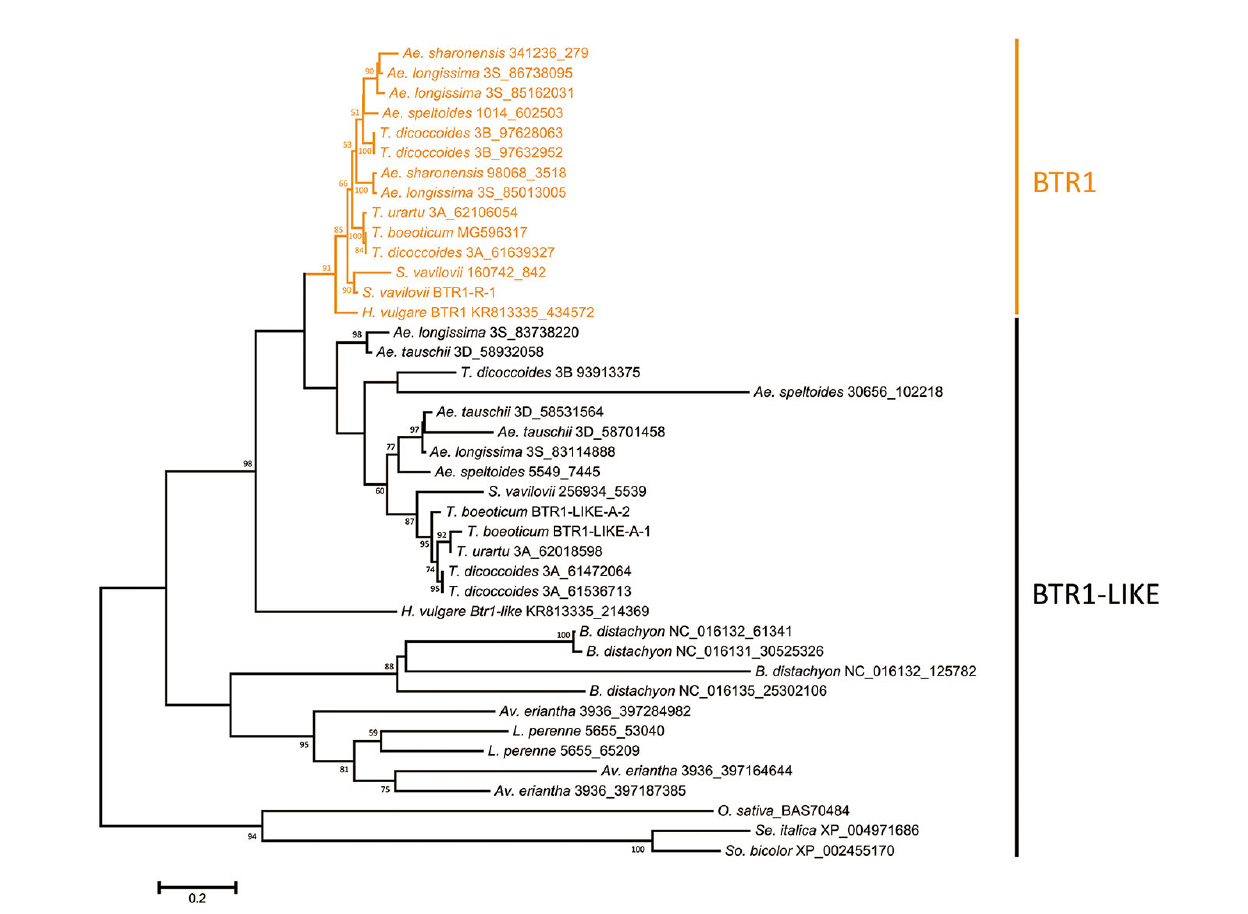
FIGURE 2 | Phylogeny of the Poaceae BTR1 and BTR1-like proteins. The tree was constructed using the maximum likelihood method based on an alignment of deduced polypeptide sequences. The products of the Btr1 genes are shown in orange. Numbers given at a branch node indicate bootstrap probabilities (only those > 50% are shown). Accession/scaffold/contig numbers and the start location of each gene is given in Table S3